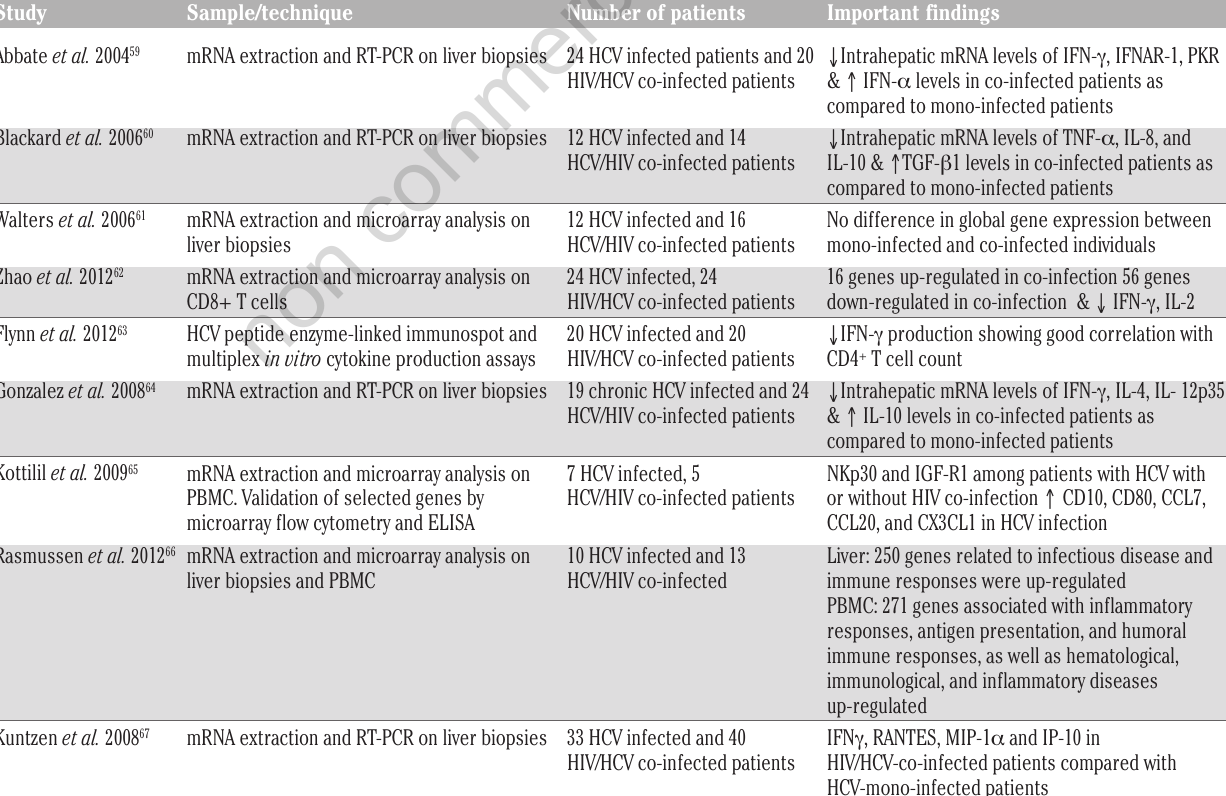
Table 1. Gene expression studies showing identified genes known to be altered during Hepatitis C Virus/HIV co-infection.